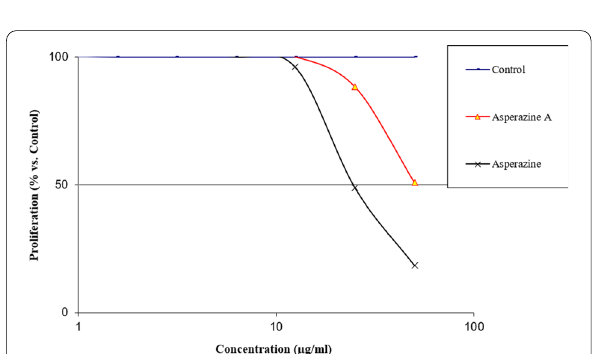
Fig. 5 Antiproliferative effects of asperazine (1) and asperazine A (2) on